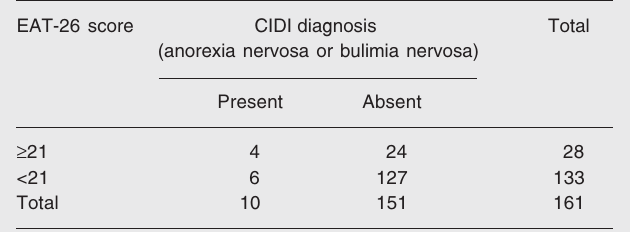
Table 3. Comparison between the diagnosis by the Composite Interna- tional Diagnostic Interview (CIDI) and the scores in the Eating Attitudes Test-26 (EAT-26) (N = 161).